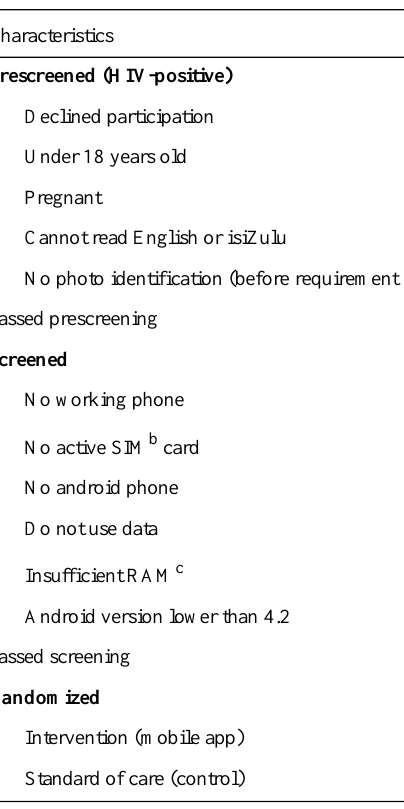
Table 1. Recruitment cascade with reasons for